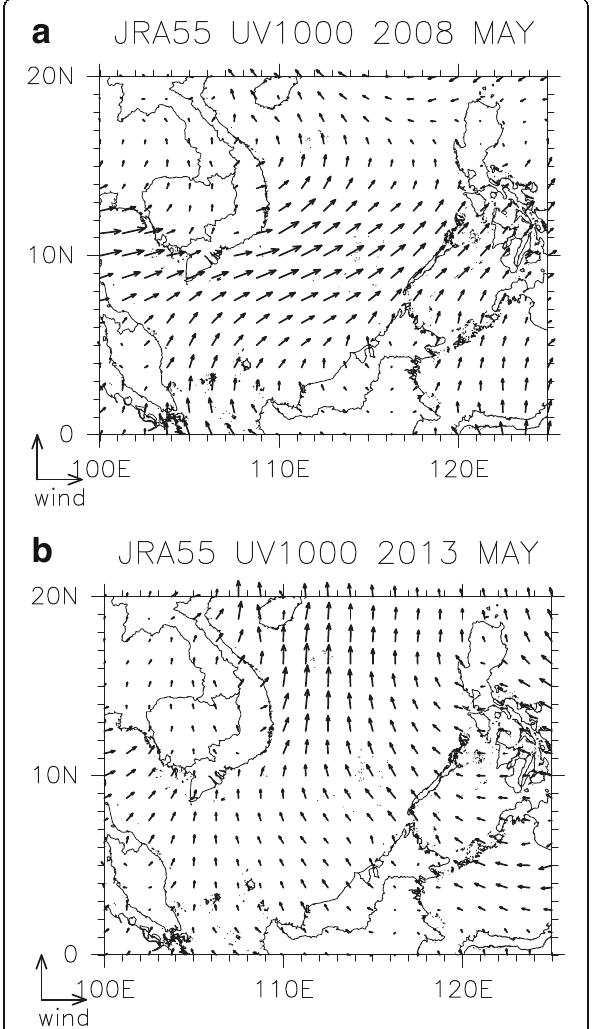
Fig. 6 Monthly averaged horizontal wind at 1000 hPa in May in a 2008 and b 2013. Unit vectors represent 12.5